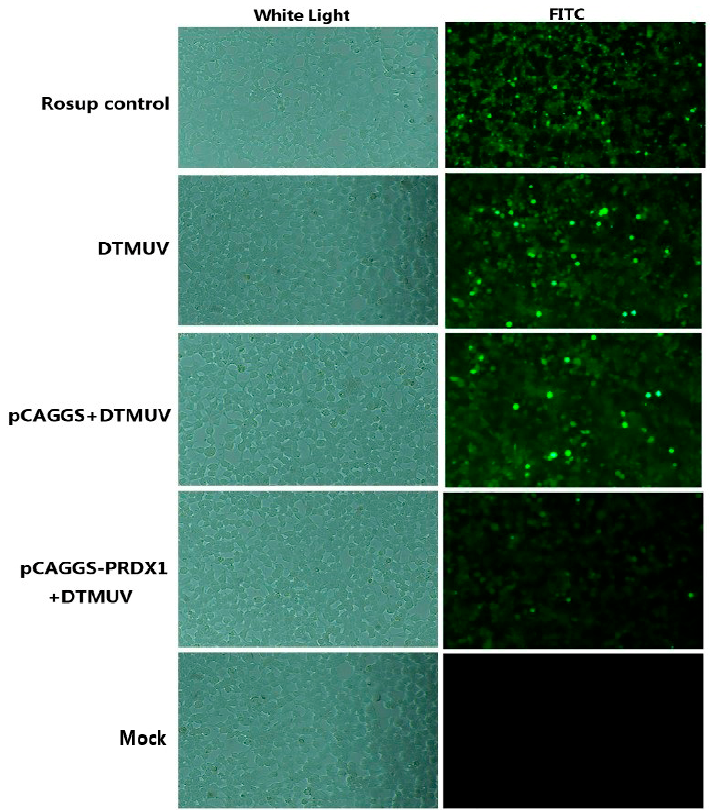
Figure 5. Determination of intracellular ROS levels. Rosup control, positive control; duck